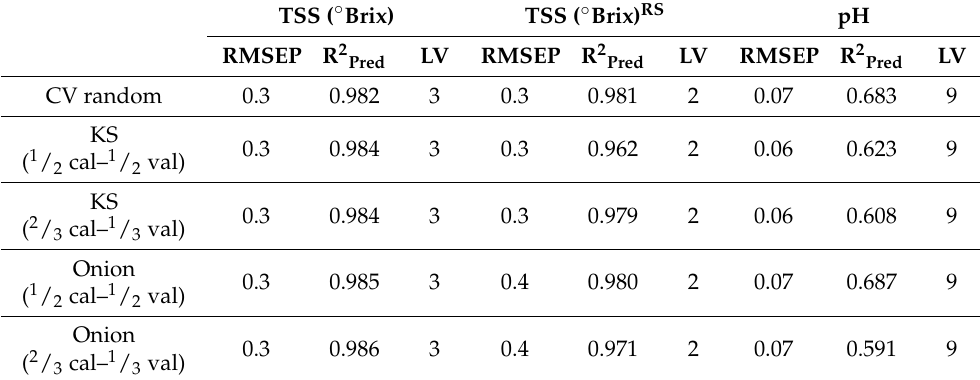
Table 2. Prediction results of total soluble solids (TSS) and pH for different validation strategies. RMSEP values for TSS are expressed in Brix. (R 2 Pred = determination coefficient of the regression line between predicted and measured values, RS = region selection, LV = number of latent variables of the model), KS = Kennard–Stone algorithm to select the validation set, onion = onion algorithm to select the validation set. TSS ( ◦